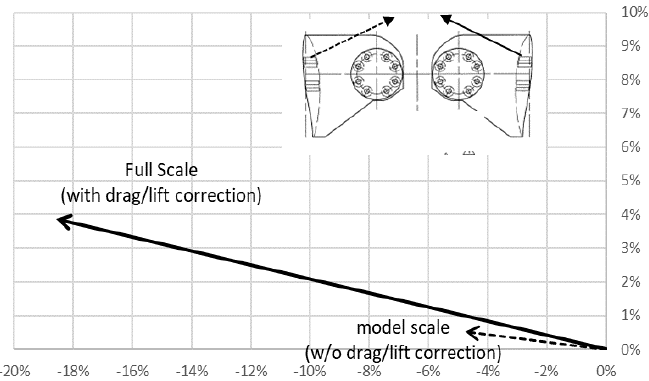
Figure 10. Effect of rudder drag and lift correction on rudder resultant force (model point case) to ship resistance.